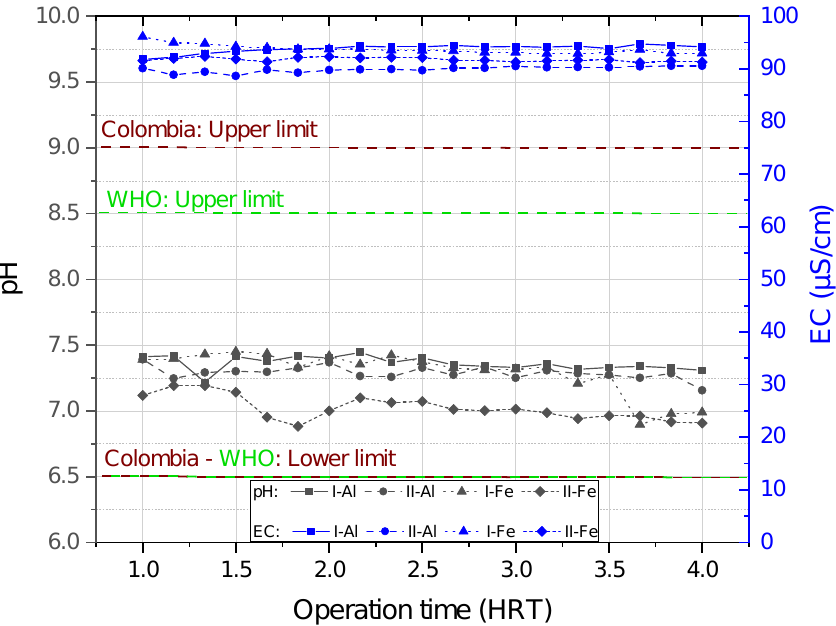
Figure 7. Average results of pH and EC in effluent from the